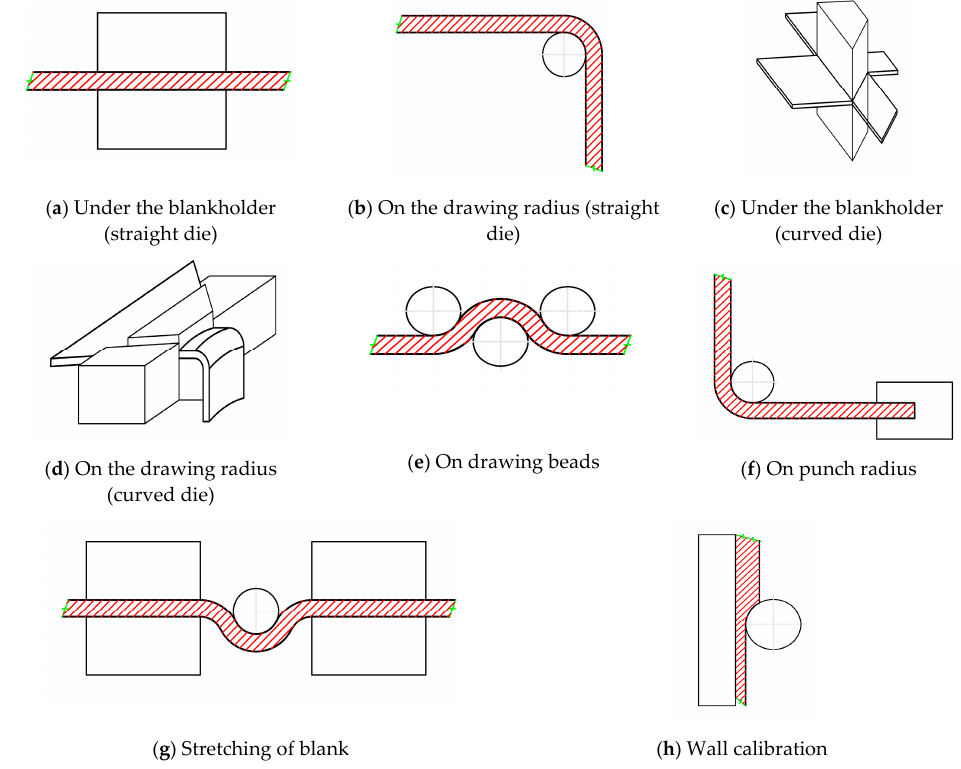
Figure 1. Types of contacts at deep drawing.